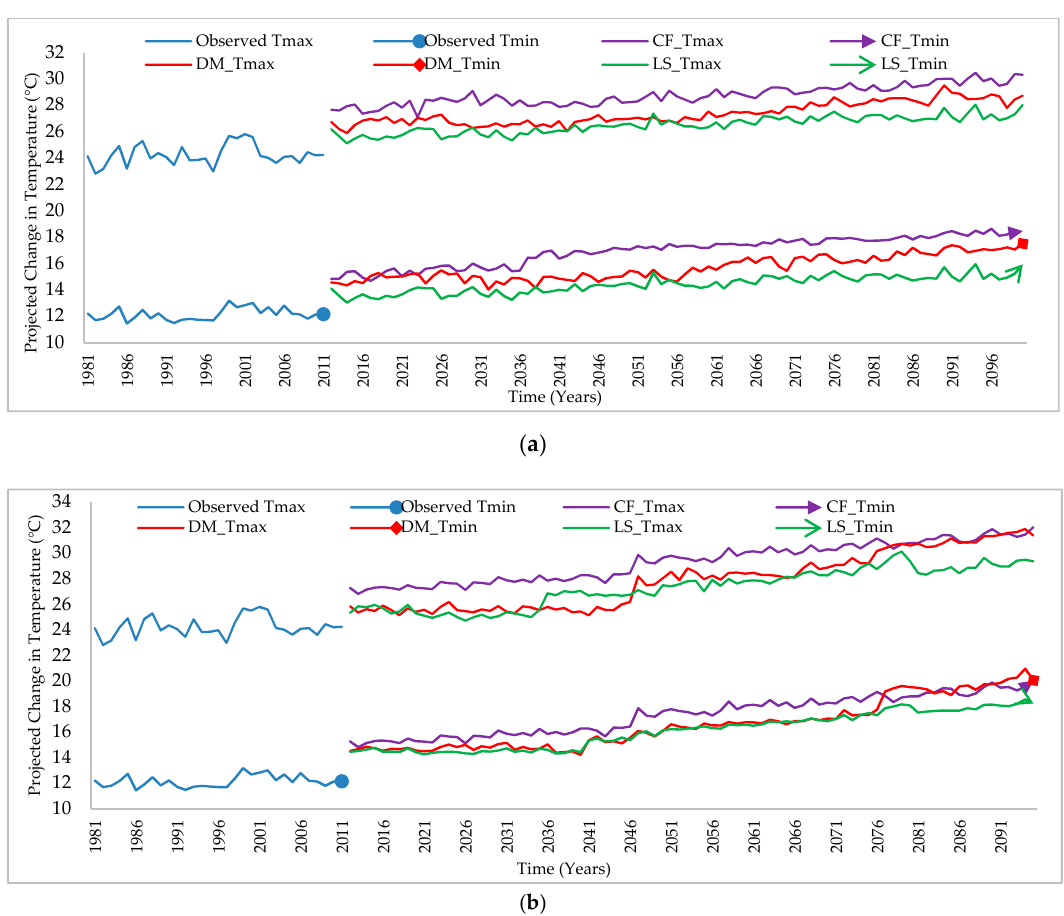
Figure 10. GCMs ensembled average temperature from 1981 to 2100 under three downscaling techniques; ( a ) RCP 4.5, ( b ) RCP 8.5.